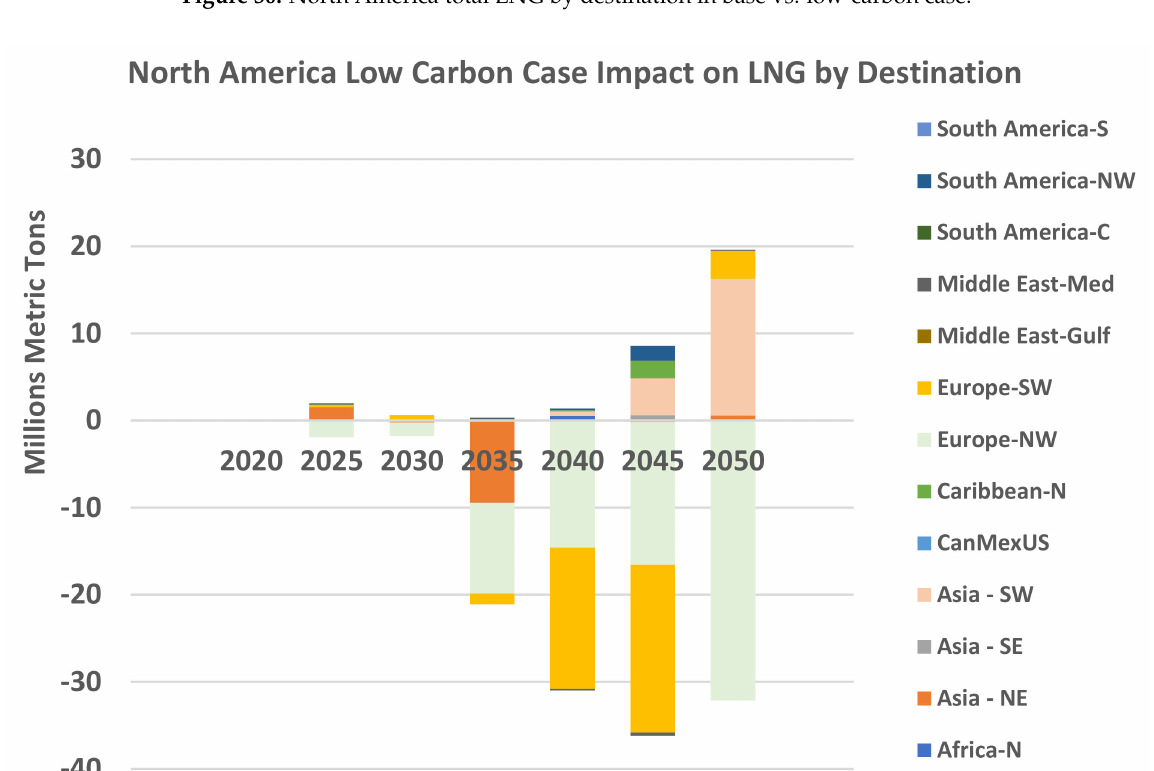
Figure 30. North America total LNG by destination in base vs. low-carbon case.